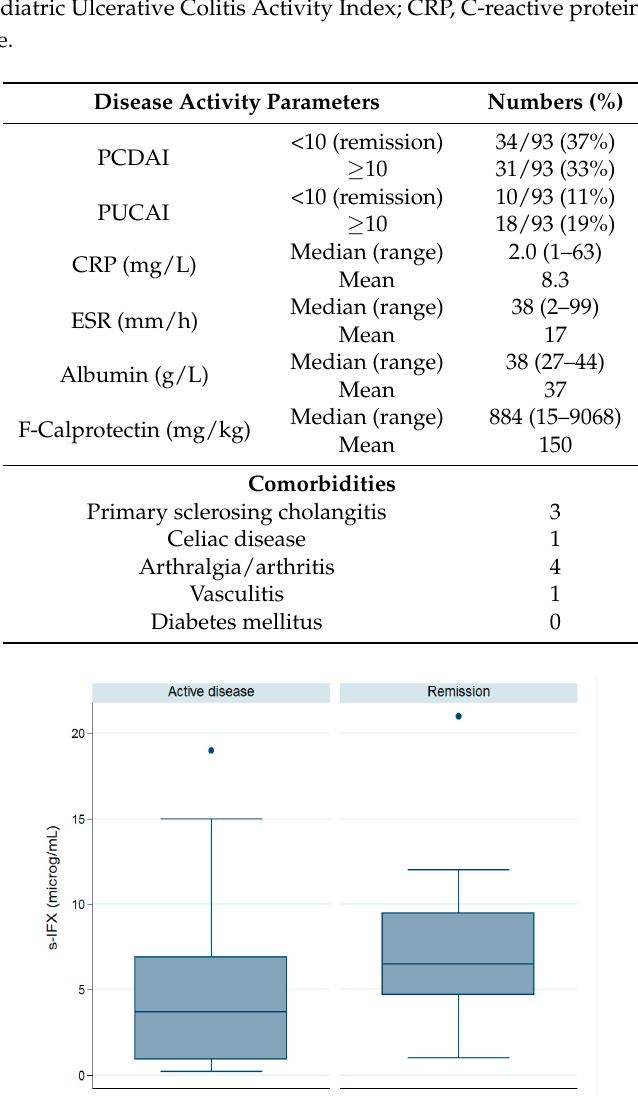
Figure 2. The mean trough s-IFX level was significantly higher in the samples taken during remission (7.2 µg/mL) as compared with s-IFX in active disease (4.5 µg/mL, p < 0.05). Clinical remission was assessed from activity scoring: PCDAI < 10 or PUCAI < 10, ESR < 10, and CRP < 5. One outlier of 40 µg/mL was excluded.